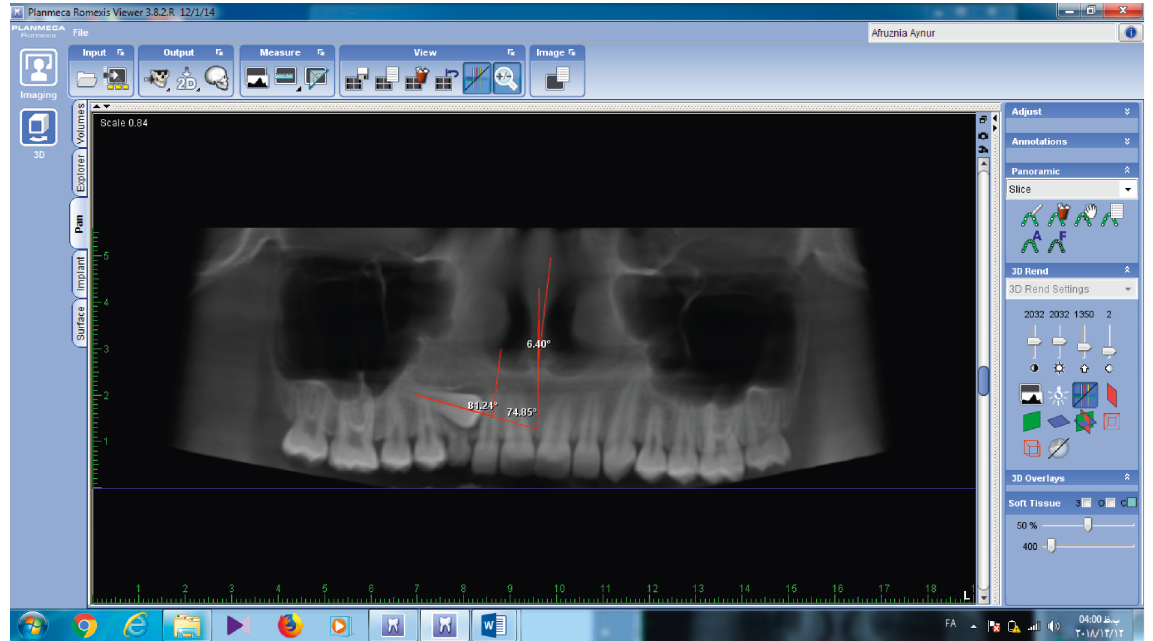
Figure 4: Measurement of canine angle with midline, canine angle with lateral, and lateral angle with midline on reformatted panoramic images of CBCT.